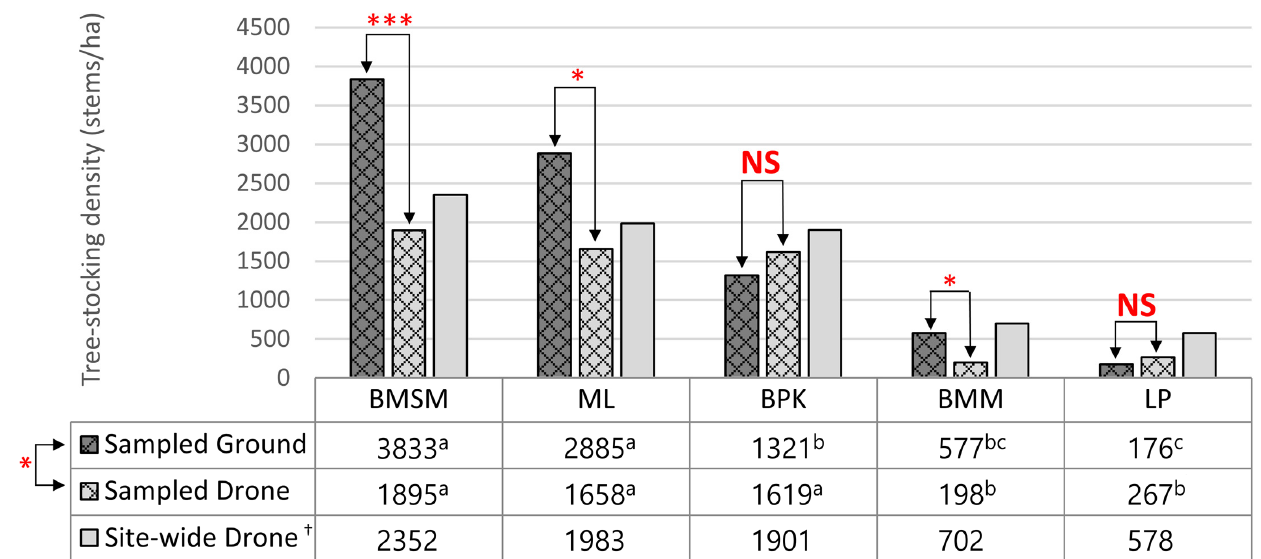
Figure 5. A comparison of mean stocking density estimates at Ban Mae Sa Mai (BMSM), Mon Long (ML), Ban Pong Krai (BPK), Ban Meh Meh (BMM), and the Lampang quarry (LP), among ground-